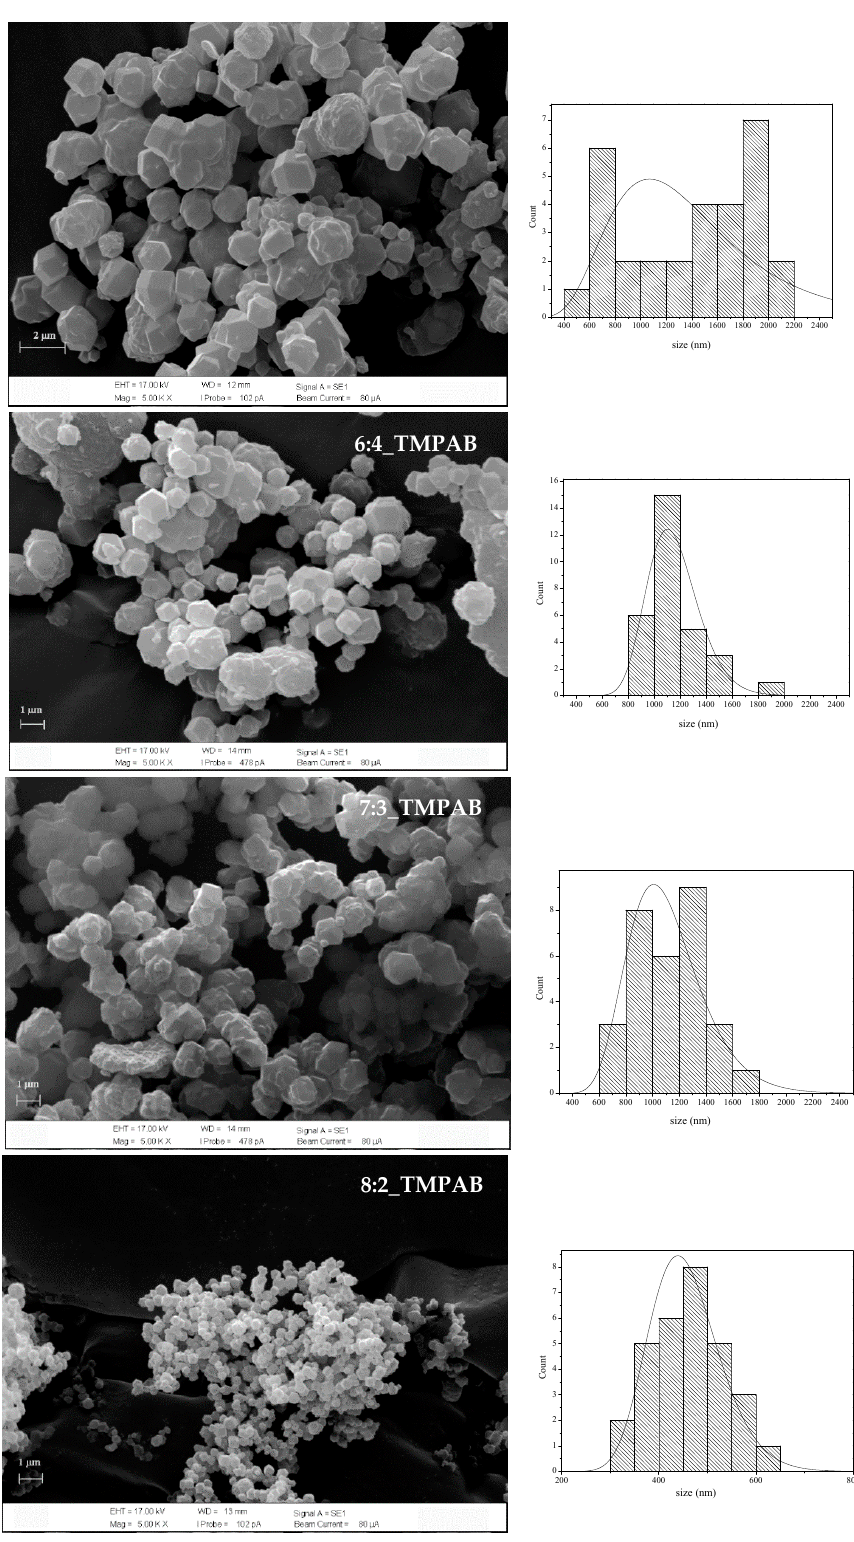
Figure 7. SEM images of synthesized ZIF-8 with various ratios between 2-MeIM and